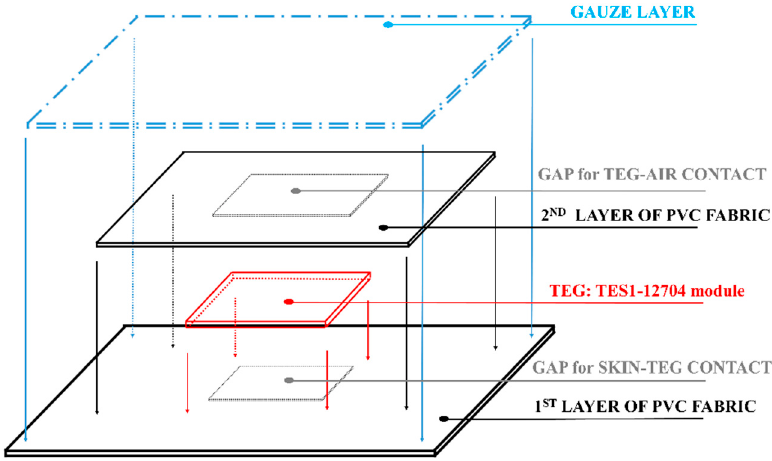
Figure 3. The manufacturing steps for the band development.